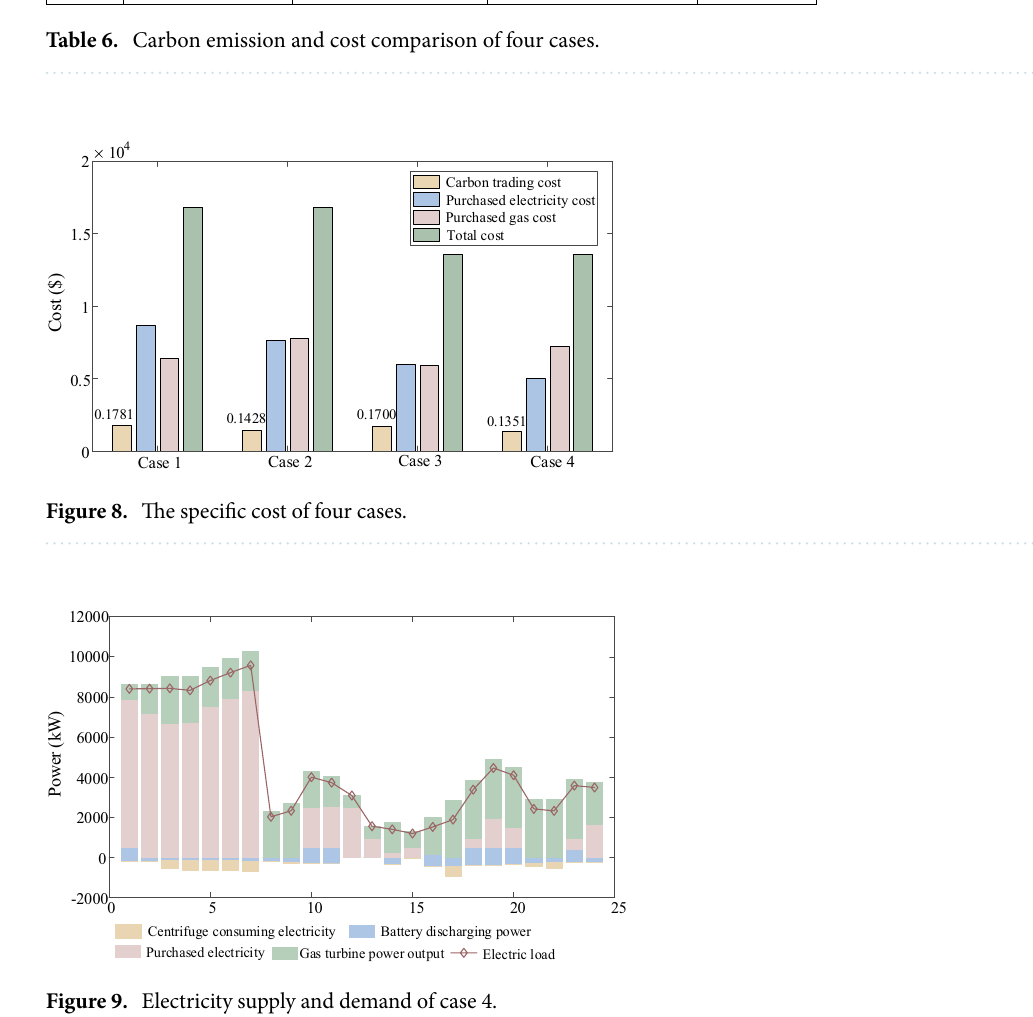
Figure 9. Electricity supply and demand of case